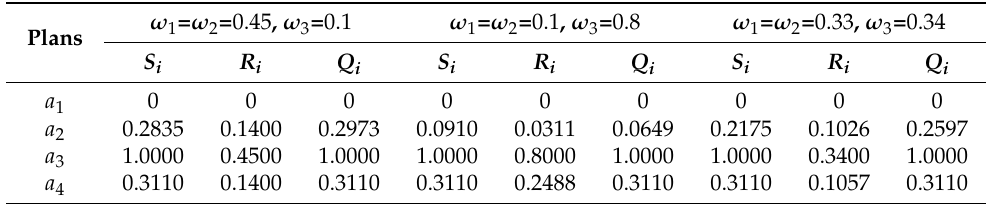
Table 16. The value of S i , R i and Q i of each scheme of the expropriated person under different criteria